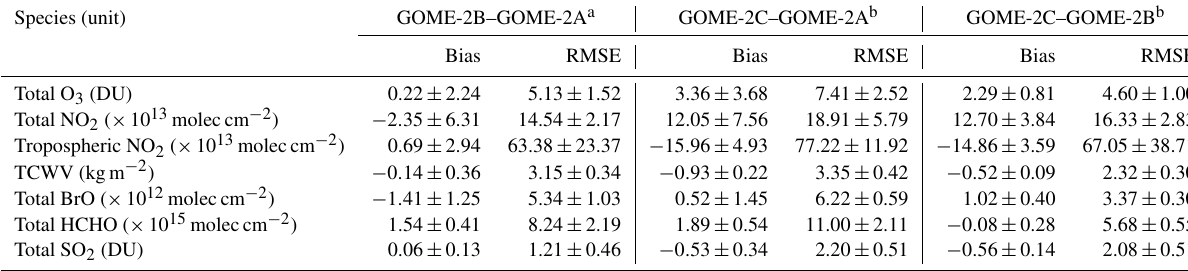
Table 2. Bias and root mean square error of trace gas columns among the three GOME-2 sensors. Species